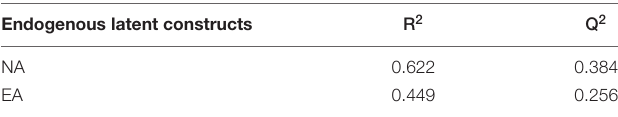
TABLE 4 | Fit indices for the four models in the study. Endogenous latent constructs R 2